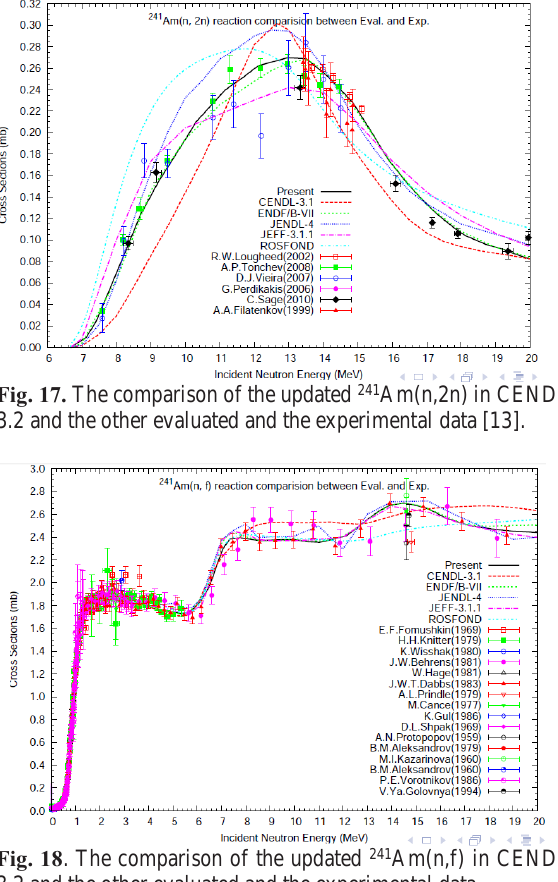
Fig. 19 . Results for HEU systems